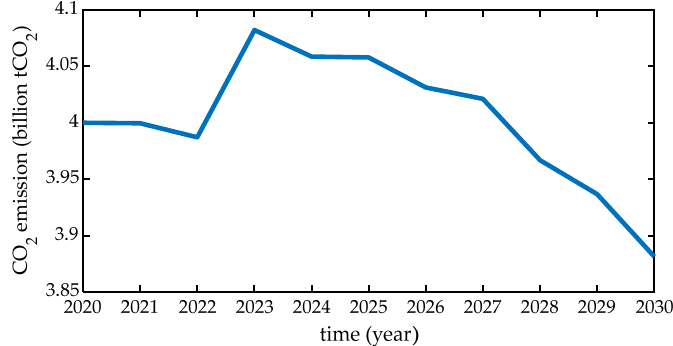
Figure 7. Emission pathway of the power industry .